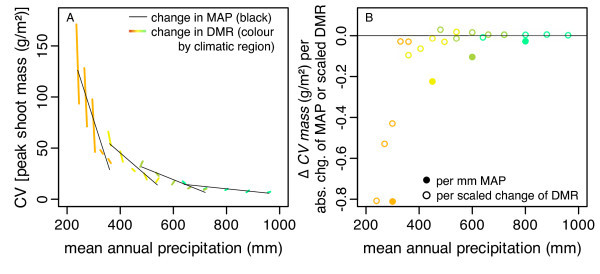
Temporal variability of peak shoot mass of populations. A) Change of coefficient of variation (CV) of peak shoot mass with mean annual precipitation (MAP, thin lines) and with amplitude of daily mean rain (DMR, thick lines, 20% change of DMR scaled to 10 mm MAP). B) Absolute changes of CV expressed per absolute change of MAP (filled circles) or MAP-scaled change of DMR (outline circles). The arid region was excluded because most populations did not persist for the full simulation time (30 yr).